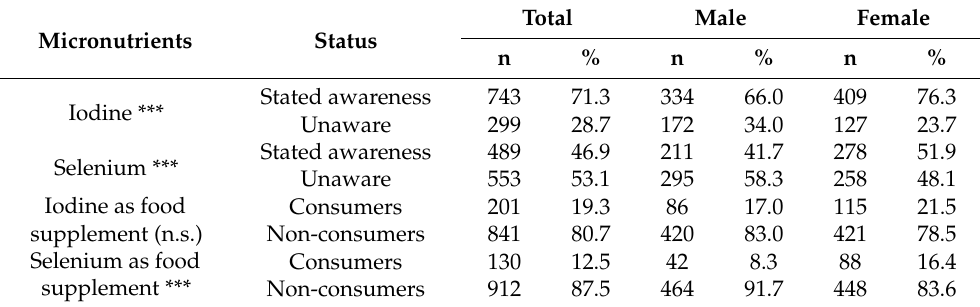
Table 4. Knowledge of selenium and iodine as well as consumption as a food supplement by gender. Micronutrients